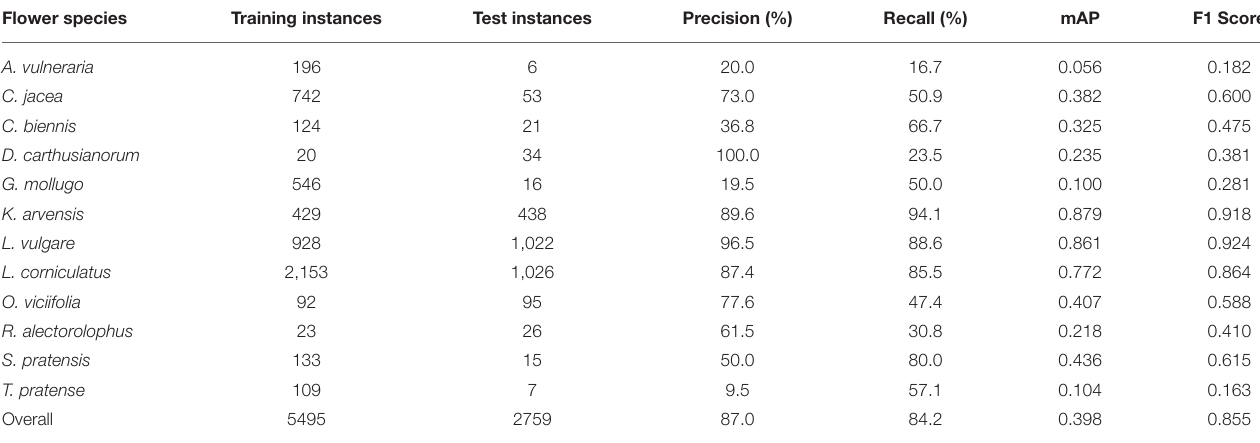
TABLE 4 | Performance of the prediction algorithm on all flower species present in the field on June 14th. Flower species Training